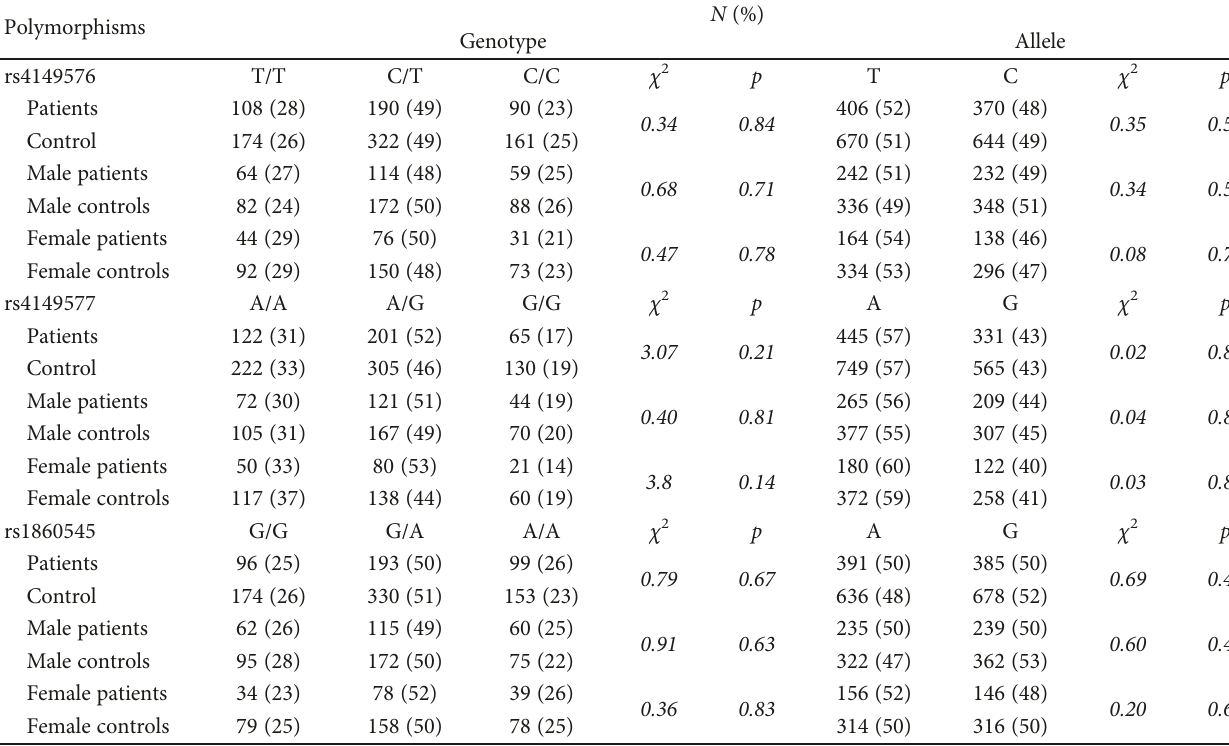
Table 1: Genotype and allele distributions for the TNFR1 (rs4149576, rs4149577, and rs1860545) polymorphisms in paranoid schizophrenia patients ( n = 388 ) and control subjects ( n = 657